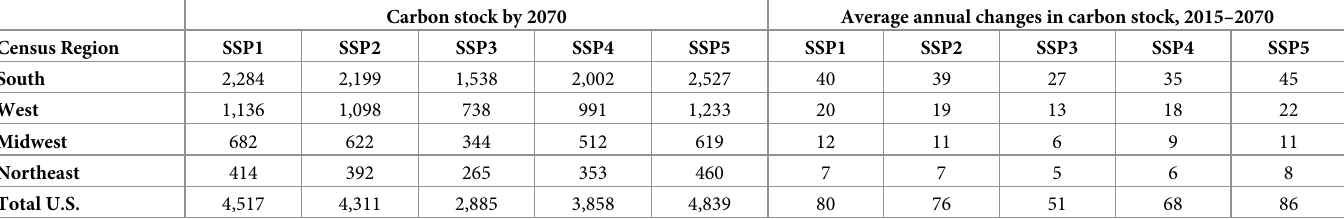
Table 4. Total and U.S. Census Region estimates of carbon stocks and average annual changes in carbon stocks (million t CO 2 e) in U.S. single-and multifamily housing units projected to be constructed, 2015–2070, by Shared Socioeconomic Pathway.